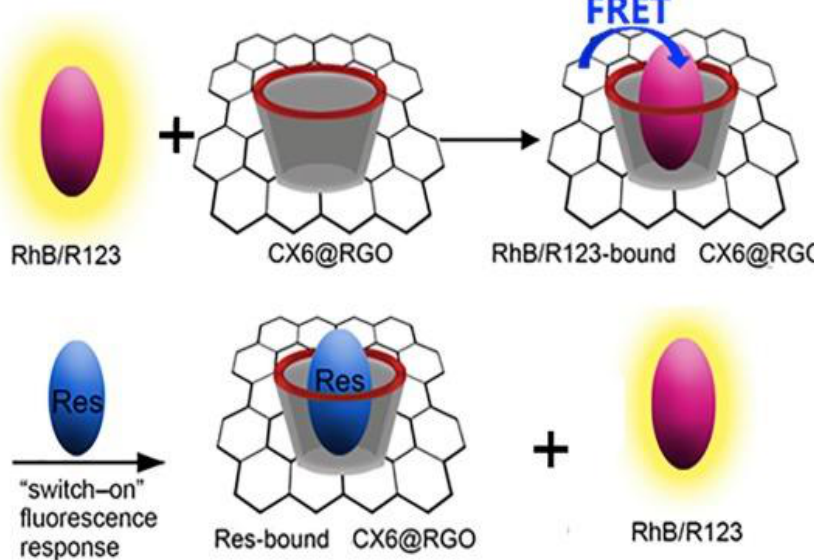
Figure 9. Displacement assay for resveratrol using calix(6)arene (CX6)-modified reduced graphene oxide (CX6@RGO) against a fluorescent dye. Taken form Li et al. [185]. oxide (CX6@RGO) against a fluorescent dye. Taken form Li et al.